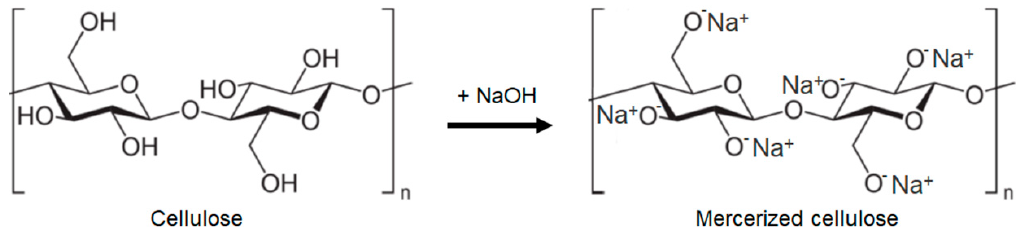
Figure 2. Mercerization (sodium hydroxide treatment) of cellulose in natural fiber cell. Reprinted with permission from [72] .